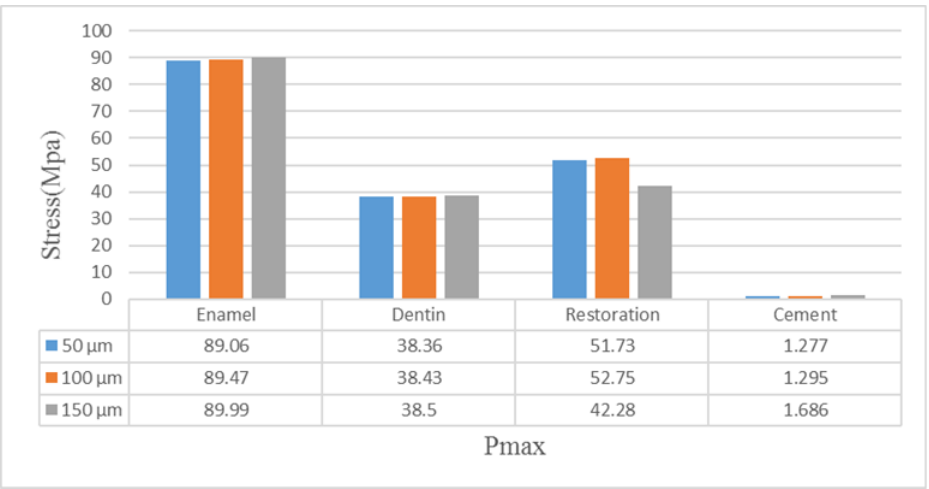
Figure 6. Maximum principal stress distribution in restorations applied with GI cements of different thicknesses (35 GP a Young’s modulus of amalgam). thicknesses (35 GPa Young’s modulus of